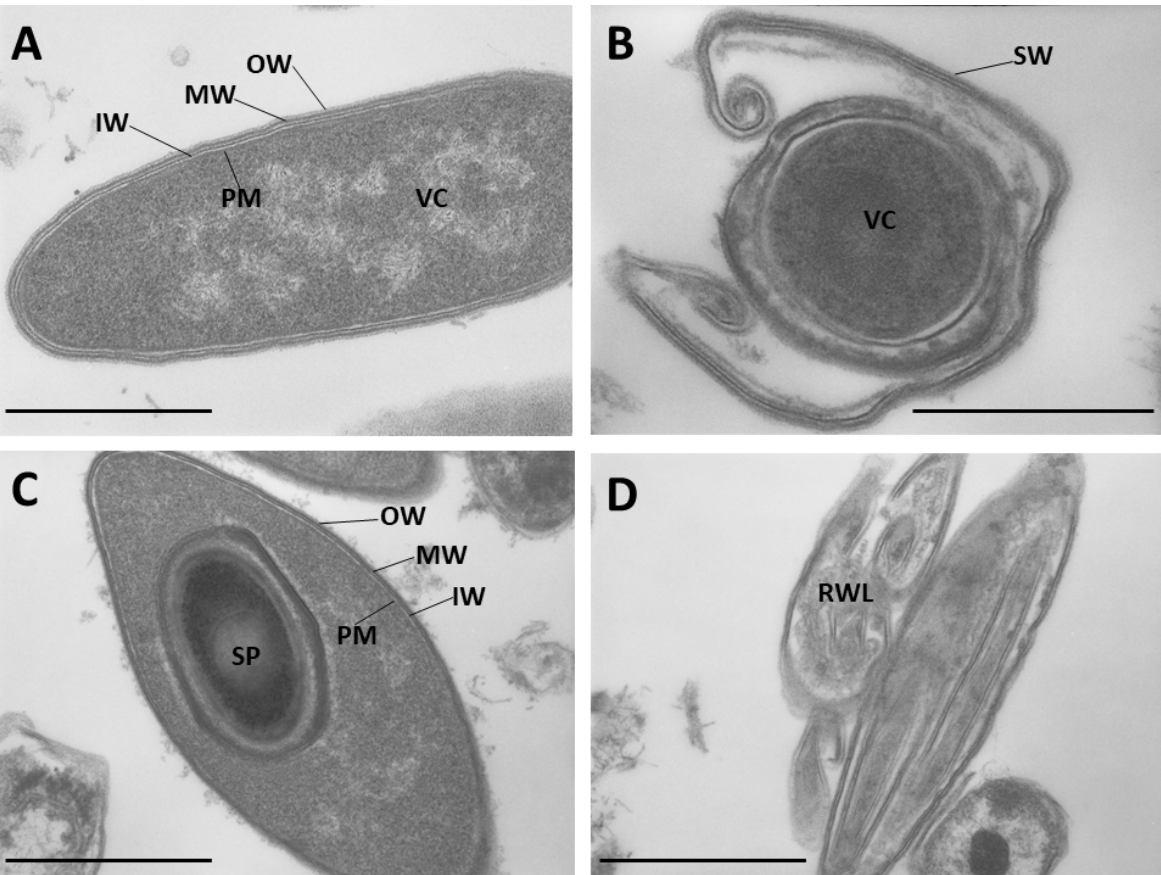
Figure 1. Brevibacillus laterosporus transmission electron microscopy (TEM) micrographs showing different bacterial structures. Vegetative cell ( A ). Cell wall shedding ( B ). Sporangium ( C ). Released cell wall multilayers ( D ). VC: vegetative cell; PM: plasma membrane; OW: outer wall layer; MW: middle wall layer; IW: inner wall layer; SW: shedding wall; SP: spore; RWL: released cell wall multilayers. Bar: 500 nm.